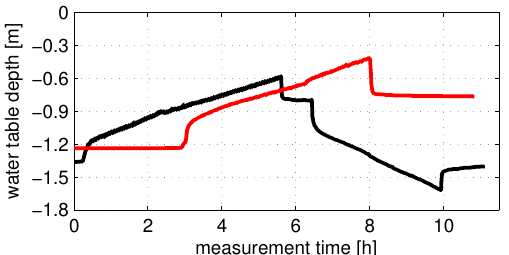
Figure 2. Variation of the water table depth below the surface over the course of experiments 1 (black line) and 2 (red line) as measured in the pumping well. The first radargrams in Figs. 6 and 10 have been acquired at time t = 0h.